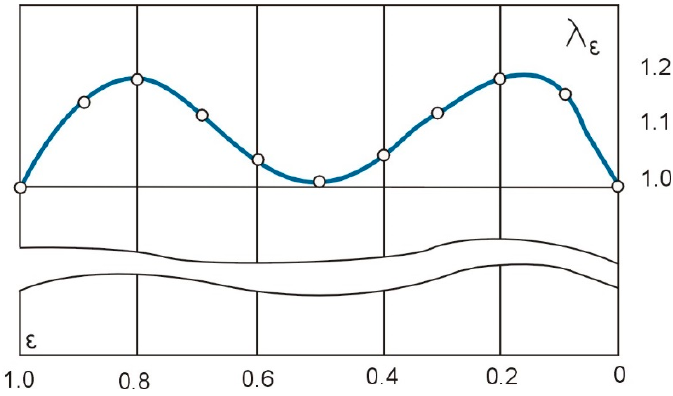
Figure 3. Curve of eccentric compliance adjustment over the machining length.